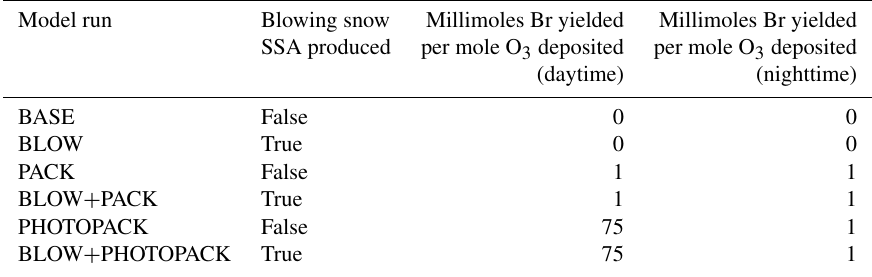
Table 1. Model run settings. Sea salt aerosol particles are produced from blowing snow as detailed in Sect. 2.5. Daytime is defined as when the solar elevation angle is greater than 5 ◦ , and nighttime is defined as when the solar elevation angle is less than 5 ◦